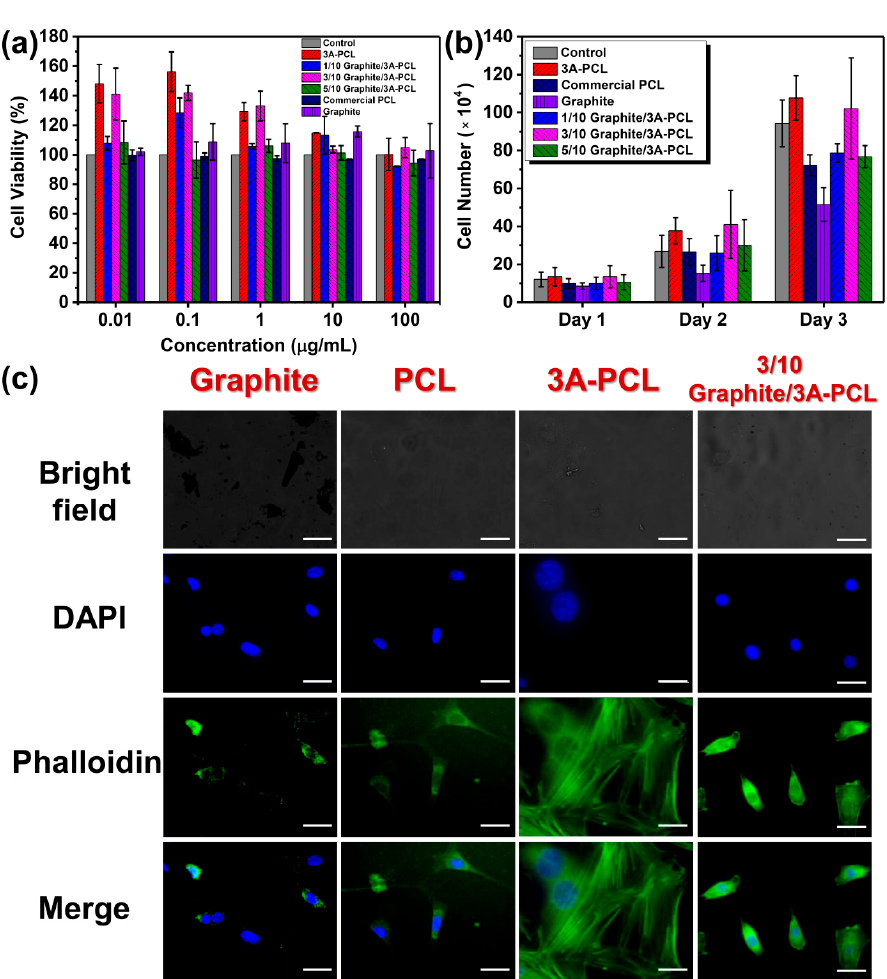
Figure 3. ( a ) The viability of NIH/3T3 cells incubated with pristine graphite, PCL, 3A-PCL, and graphite/3A-PCL composites for 24 h. These viability results were obtained by MTT assay. ( b ) The numbers of NIH/3T3 cells on the graphite, PCL, 3A-PCL, and graphite/3A-PCL substrates after 1–3 days of culture. ( c ) CLSM images of NIH/3T3 cells cultured on pristine graphite, PCL, 3A-PCL, and 3/10 graphite/3A-PCL substrates. After 24 h of culture, the resulting cells were stained with